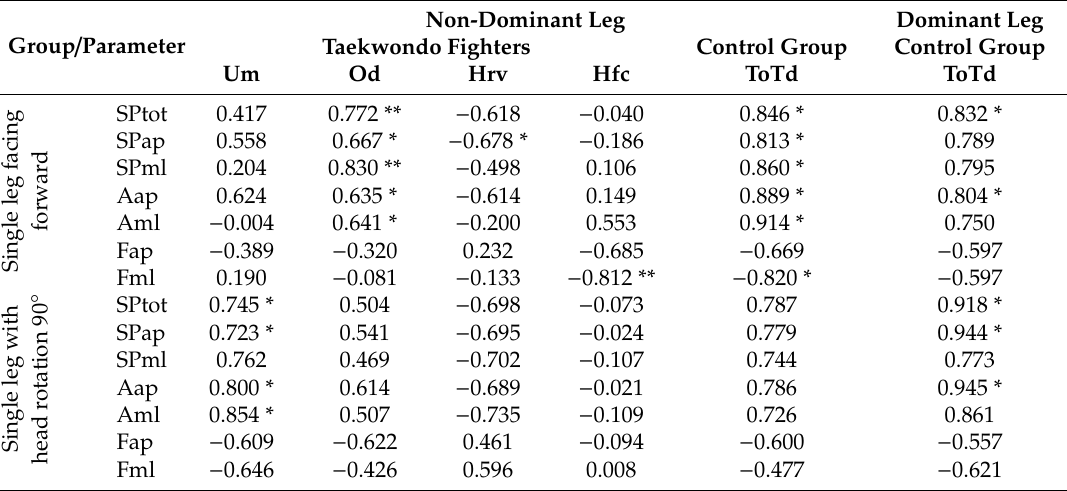
for the Head-to-Neutral Relocation test from flexion; Od—overshoot standard deviation of the Butterfly test; Um—undershoot standard deviation of the Butterfly test; SPtot—distance by the center of pressure movement; SPap—distance by the center of pressure movement in anterior–posterior direction; SPml—distance by the center of pressure movement in medial–lateral direction; Aap—average amplitude of center of pressure movement in anterior–posterior direction; Aml—average amplitude of center of pressure movement in medial–lateral direction; Fap—average frequency of center of pressure direction changes in anterior–posterior